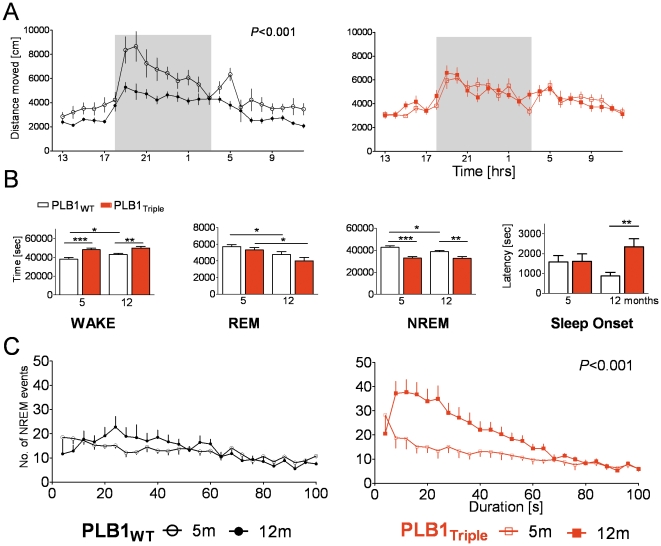
Circadian rhythm, wakefulness, and sleep architecture in PLB1WT and PLB1Triple animals at 5 and 12 months of age.
A: Circadian patterns of locomotor activity (mean distance moved ± SEM, in hourly bins over 24 hrs) were intact in PLB1Triple mice. Only PLB1WT showed higher activity at 5 months and an age-related reduction (P<0.001). B: Time (in seconds+SEM) spent in vigilance stages wakefulness (WAKE), REM and NREM sleep, and sleep onset (latency). PLB1Triple animals display increased wakefulness and corresponding reduction in NREM sleep at both ages (genotype effect: P's<0.001). REM sleep was affected by age (P<0.01) but not genotype, and onset of sleep delayed in 12 m PLB1Triple mice (P<0.01). C: A highly significant age-related increase in the number of short-duration NREM events was uncovered in PLB1Triple (right) but not PLB1WT mice (left). Data represent mean +/− SEM. *: P<0.05; **:P<0.01; ***: P<0.001.